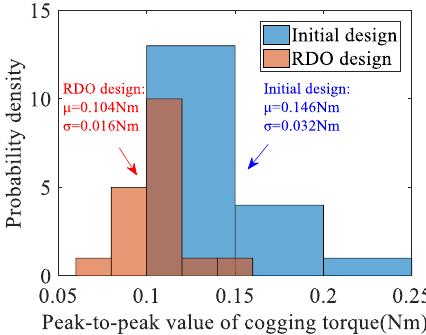
Figure 19. T cpp distribution of initial and RDO schemes in prototypes.